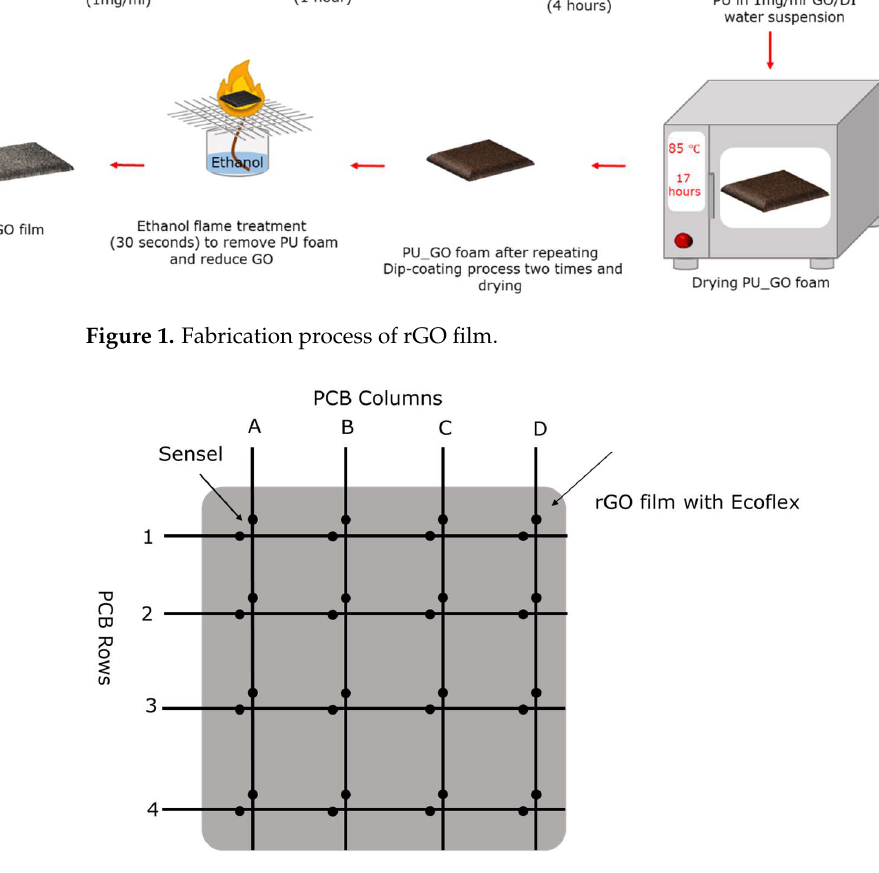
Figure 1. Fabrication process of rGO film.